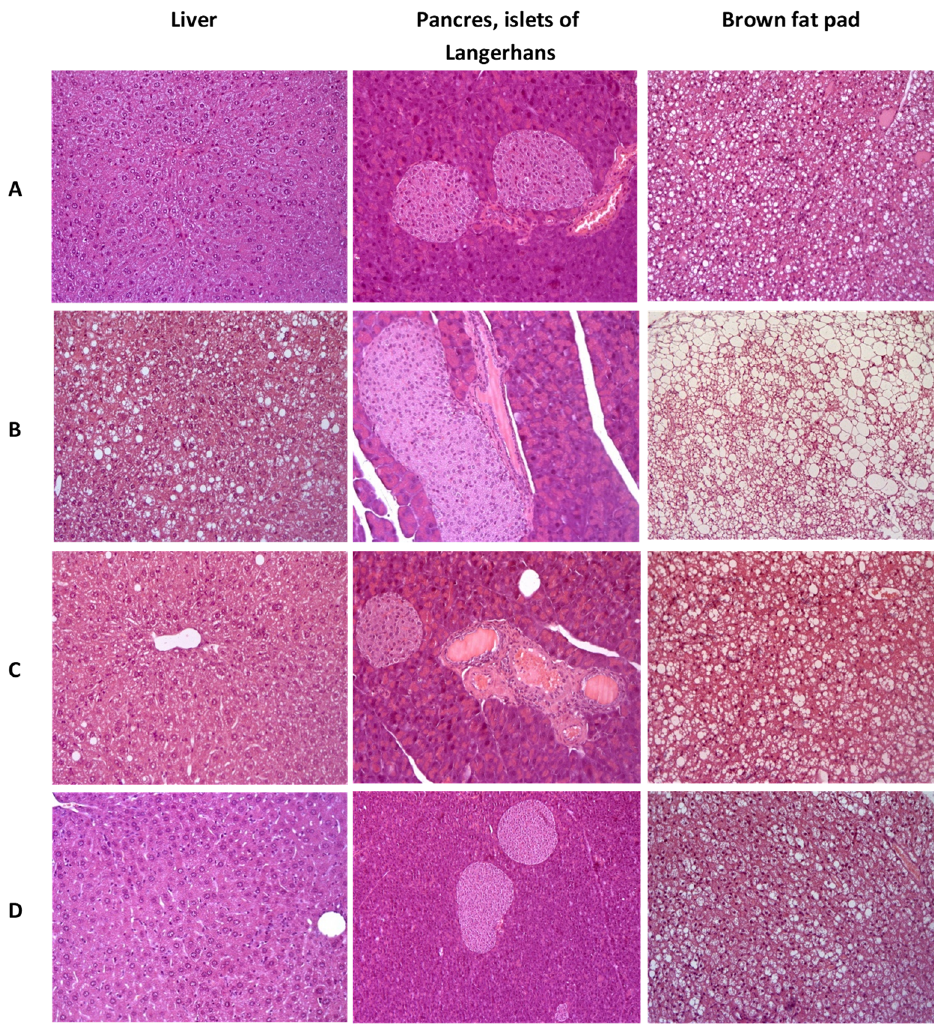
Figure 9. Histologial evaluation of liver, pancreas, and brow fat pad in mice after 3 weeks of experiment. ( A )—C57Bl/6 (healthy control), ( B )—AY mice (untreated), ( C )—AY mice treated by metformin at a dose of 250 mg/kg, ( D )—AY mice treated by SHE-196 at a dose of 15 mg/kg. Hematoxylin and eosin staining, ×200.